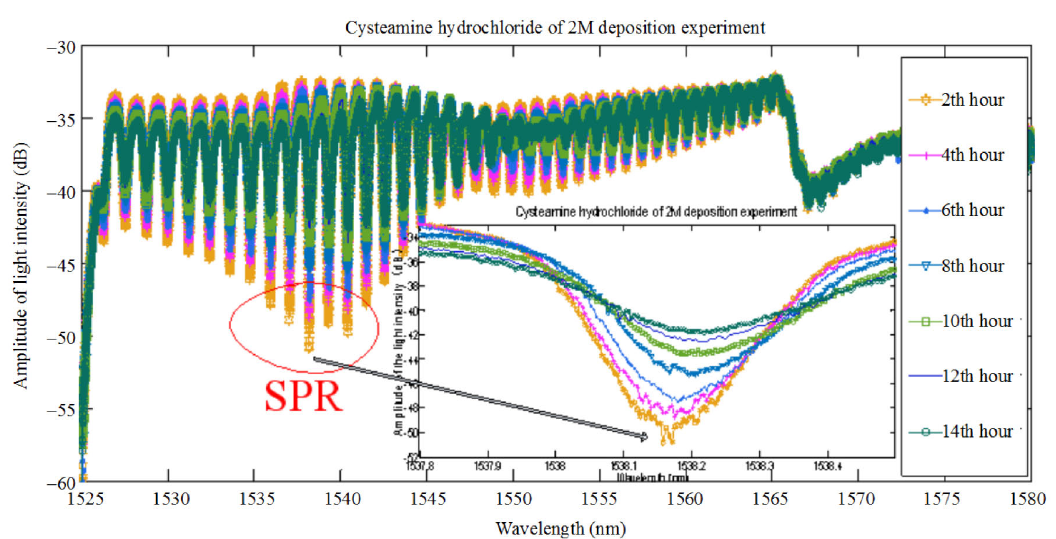
Fig. 4 Results of 2 M cysteamine hydrochloride deposition resonance peak wavelength.